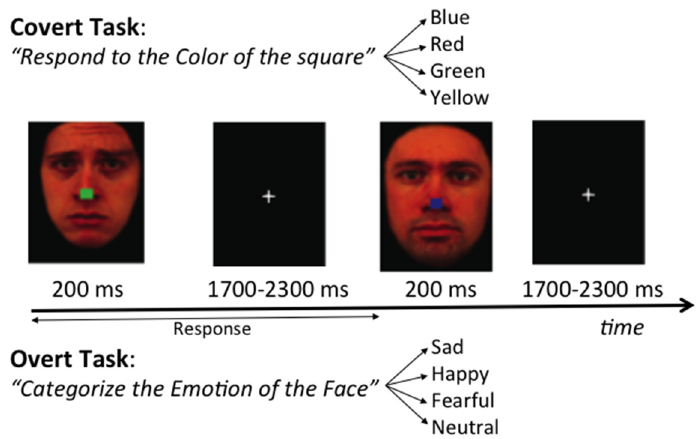
Figure 1. Trial sequence in the Covert and Overt Emotion Tasks.